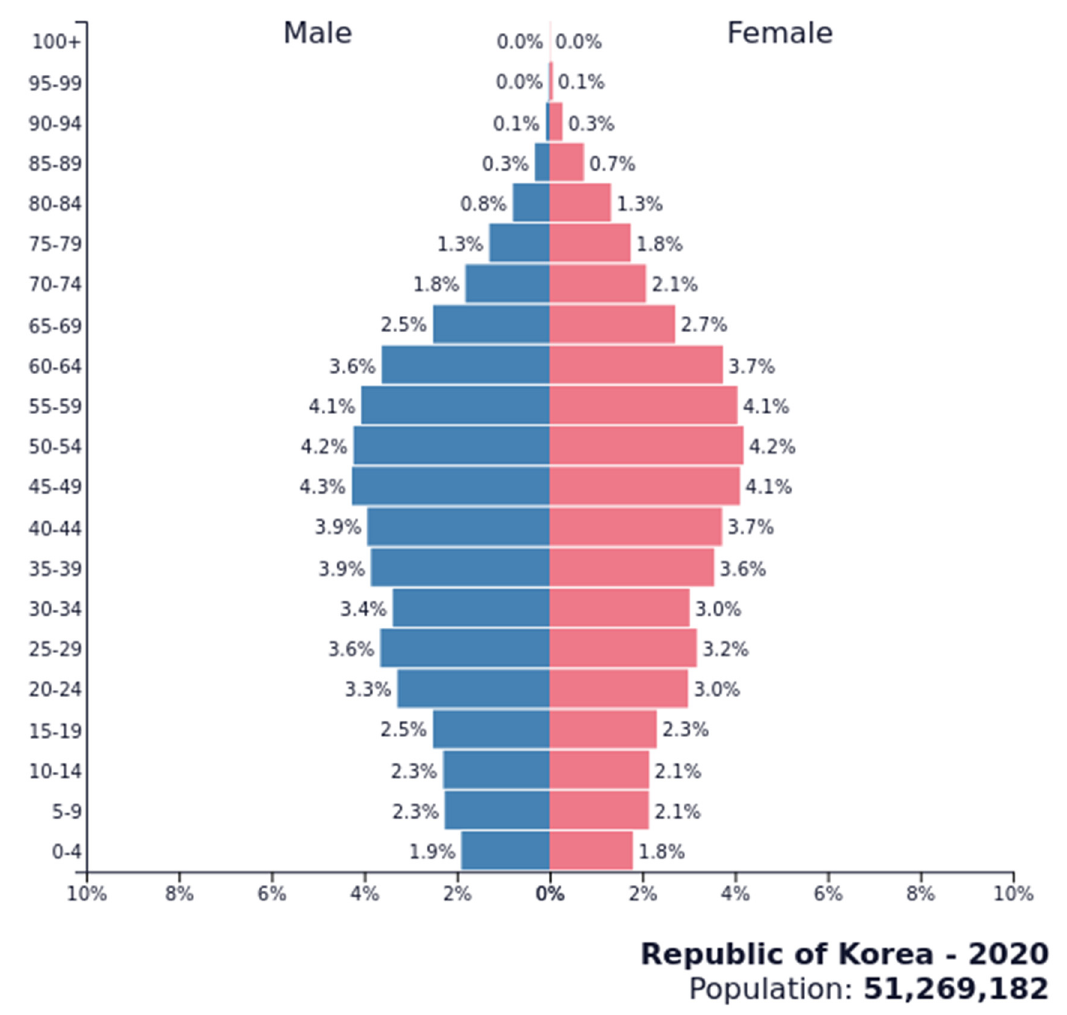
Figure 3. Population pyramid of South Korea. Source: https://www.populationpyramid.net [46].